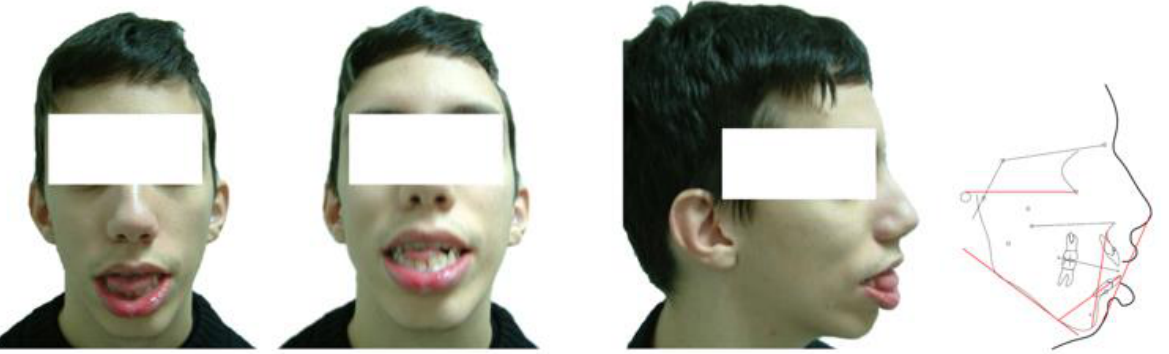
Figure 1. Patient P1: portrait photographs and cephalometric tracing of a male FSHD patient, 19 years old who presented with documented early onset of the disease and a genetic testing showing a substantial fragment. The patient was identified as a sporadic case. The clinical screening as well as the cephalometric analysis revealed a long ovoid face with increased anterior lower facial height, anterior open bite and posterior bilateral crossbite. The lips were severely incompetent and protrusive and the tongue was oversized.